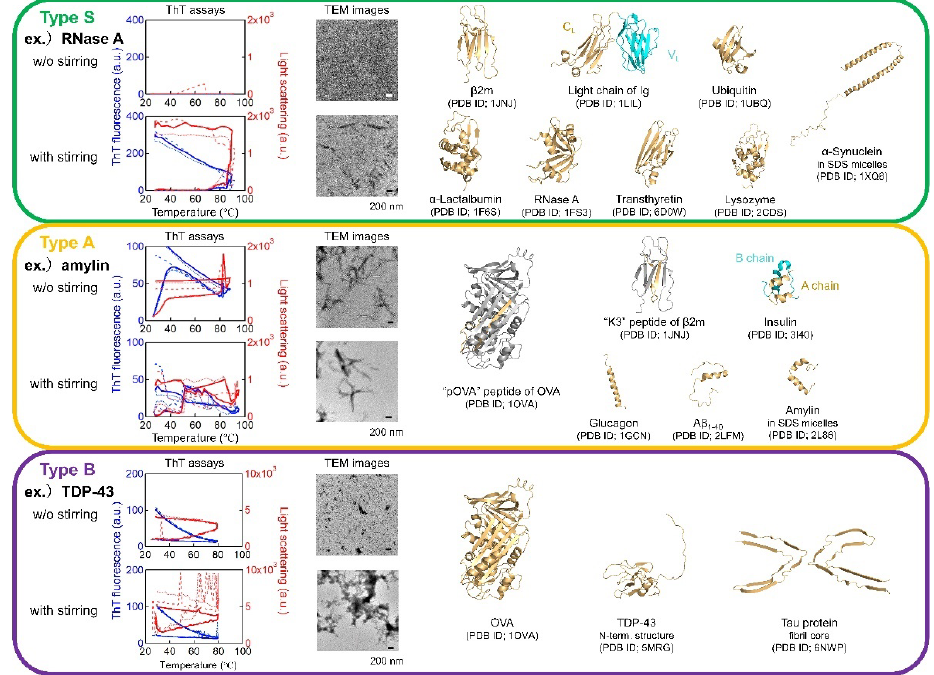
Figure 2. Heating- and agitation-dependent amyloid formation of proteins. According to their aggregation behavior, Type S, A, and B proteins were defined. Left : ThT assays upon heating in the presence (upper) or absence (lower) of stirring. The intensities of ThT fluorescence and LS are indicated by blue and red lines, respectively. n = 3. Middle: TEM images of the samples after heating in the presence (upper) or absence (lower) of stirring. Right : Structures of proteins used with their names and pdb codes. The figure was created based on Noji et al. [2].